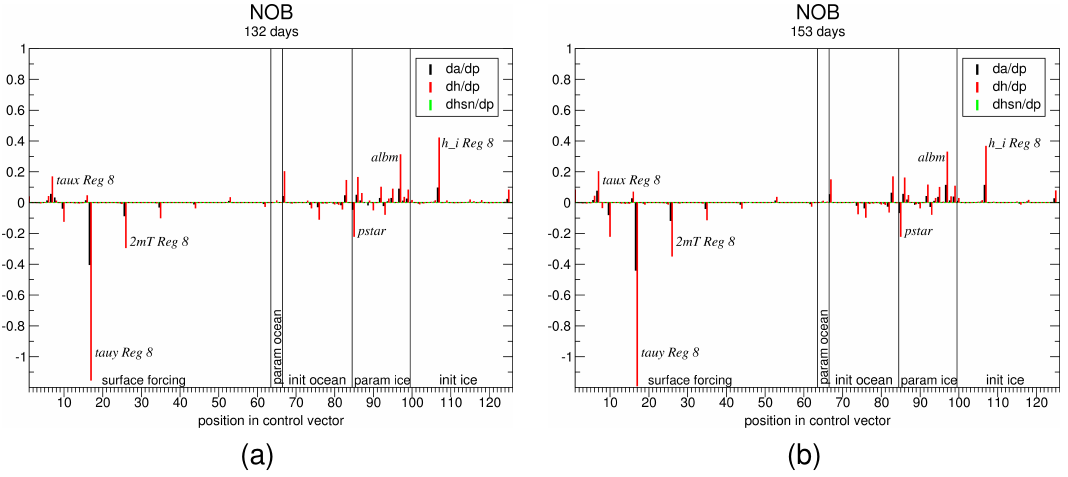
Figure 10. Sensitivity of target quantity over NOB area for 132-day (a) and 153-day (b) forecasts to 1 prior sigma uncertainty change in each control variable. Units of target quantities (and their sensitivities): ice concentration (a) (0–1); ice thickness (h) in metres; snow thickness ( hsn ) in metres.